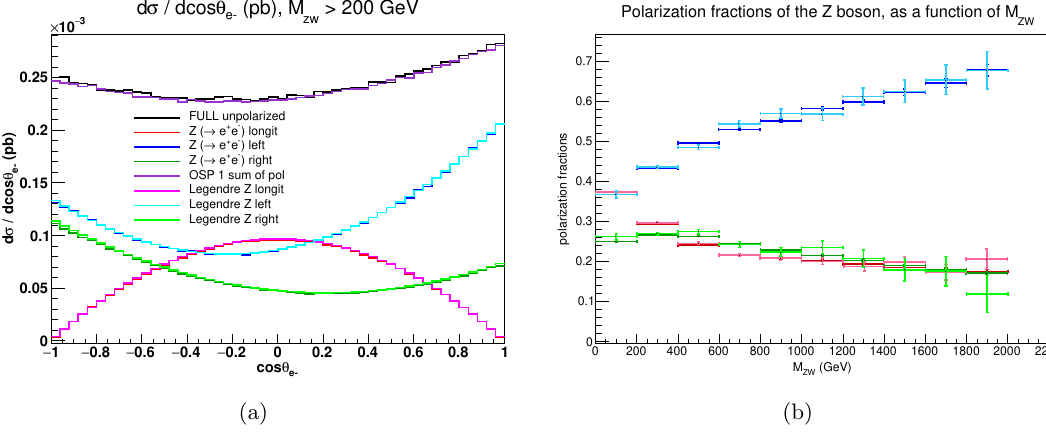
Figure 6 . W + Z scattering: cos (cid:18) distributions for a polarized Z , in the region M WZ > 200 GeV e (cid:0) (left), and polarization fractions as functions of M WZ (right). Comparison between Monte Carlo distributions and results extracted from the full cos (cid:18) distribution by projecting into the (cid:12)rst e (cid:0) three Legendre polynomials. No lepton cuts, no neutrino